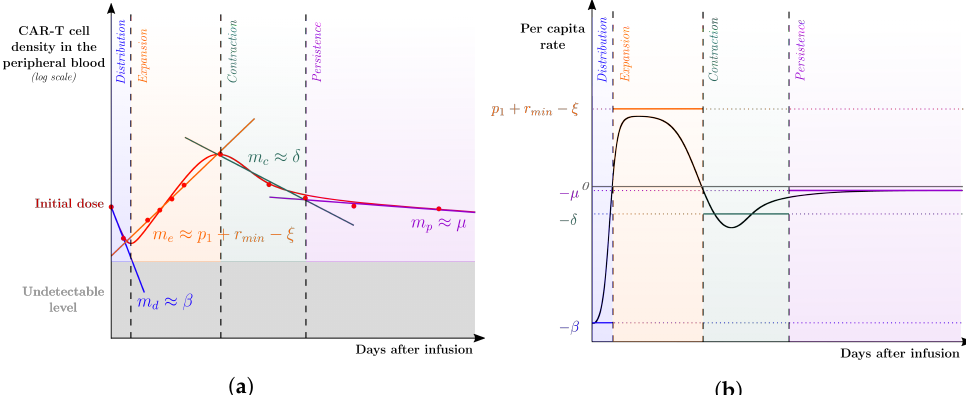
Figure 2. Schematic description of the strategy used to assess the dominant mechanisms underlying the multiphasic CAR-T cell dynamics. ( a ) Experimental data ( • ) of CAR-T cell kinetics from a representative patient profile were split among the four phases of CAR-T cell dynamics to which lines in the logplot of the CAR-T cell population along time were fitted. The corresponding (growth or decline) rates are denoted by m d , m e , m c , and m p , associated with the distribution, expansion, contraction, and persistence phases, respectively. These rates are used as first approximations to the parameters of the leading mechanism(s) of each phase. Specifically, the distribution phase is mainly driven by the reduction rate of the injected CAR-T cells so that m d ≈ β ; the expansion phase is driven by the combined effect between the C T expansion ( p 1 + r min ) and mortality ( ξ ), leading to m e ≈ p 1 + r min − ξ ; the contraction and persistence phases are mainly driven by the mortality of exhausted and memory CAR-T cells, respectively, which yield m c ≈ δ and m p ≈ µ . ( b ) The per capita rate of the total CAR-T cell population ( C D + C T + C E + C M ) is displayed over time after infusion together with the calibrated values of β , p 1 + r min − ξ , δ , and µ